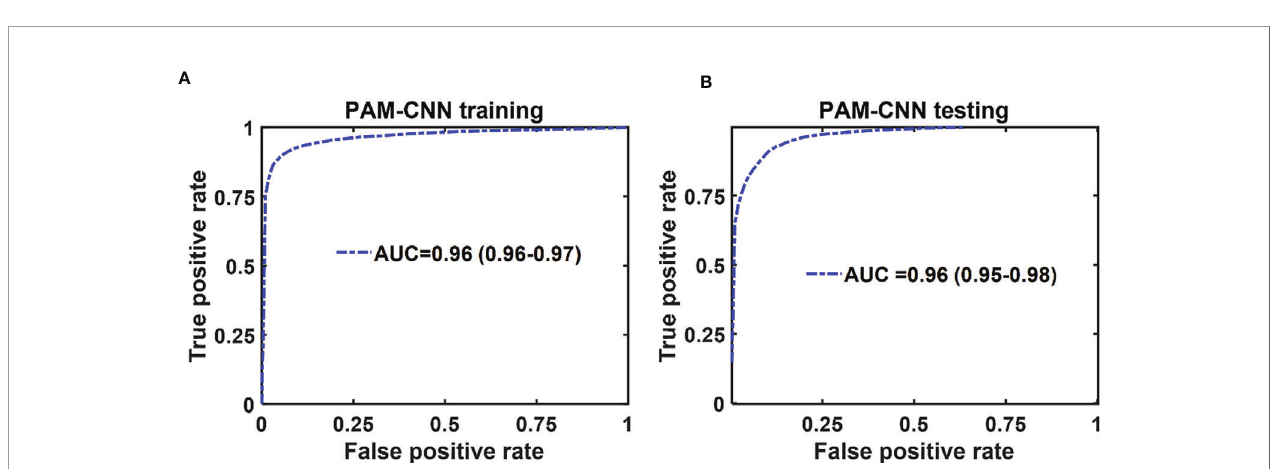
FIGURE 7 | The average ROC of the training (A) and testing (B) data sets for different combinations of features set. The features were extracted from US images. The 95% CIs are indicated in parentheses.